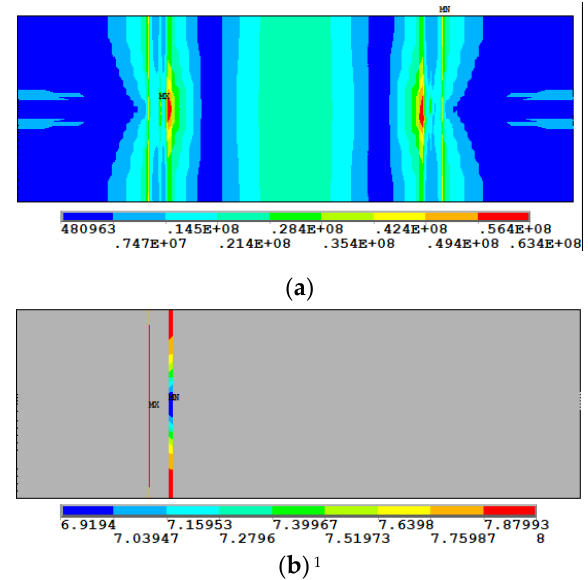
Figure 13. Mises stress of the bottom side of the top flange of the double-sided weld seam, (a) Mises stress diagram of the bottom side of the bridge deck (Pa). (b) Fatigue cyclic life of the connection of the rib-to-deck, 1 the number in the contours is the base 10 log of the contour line.